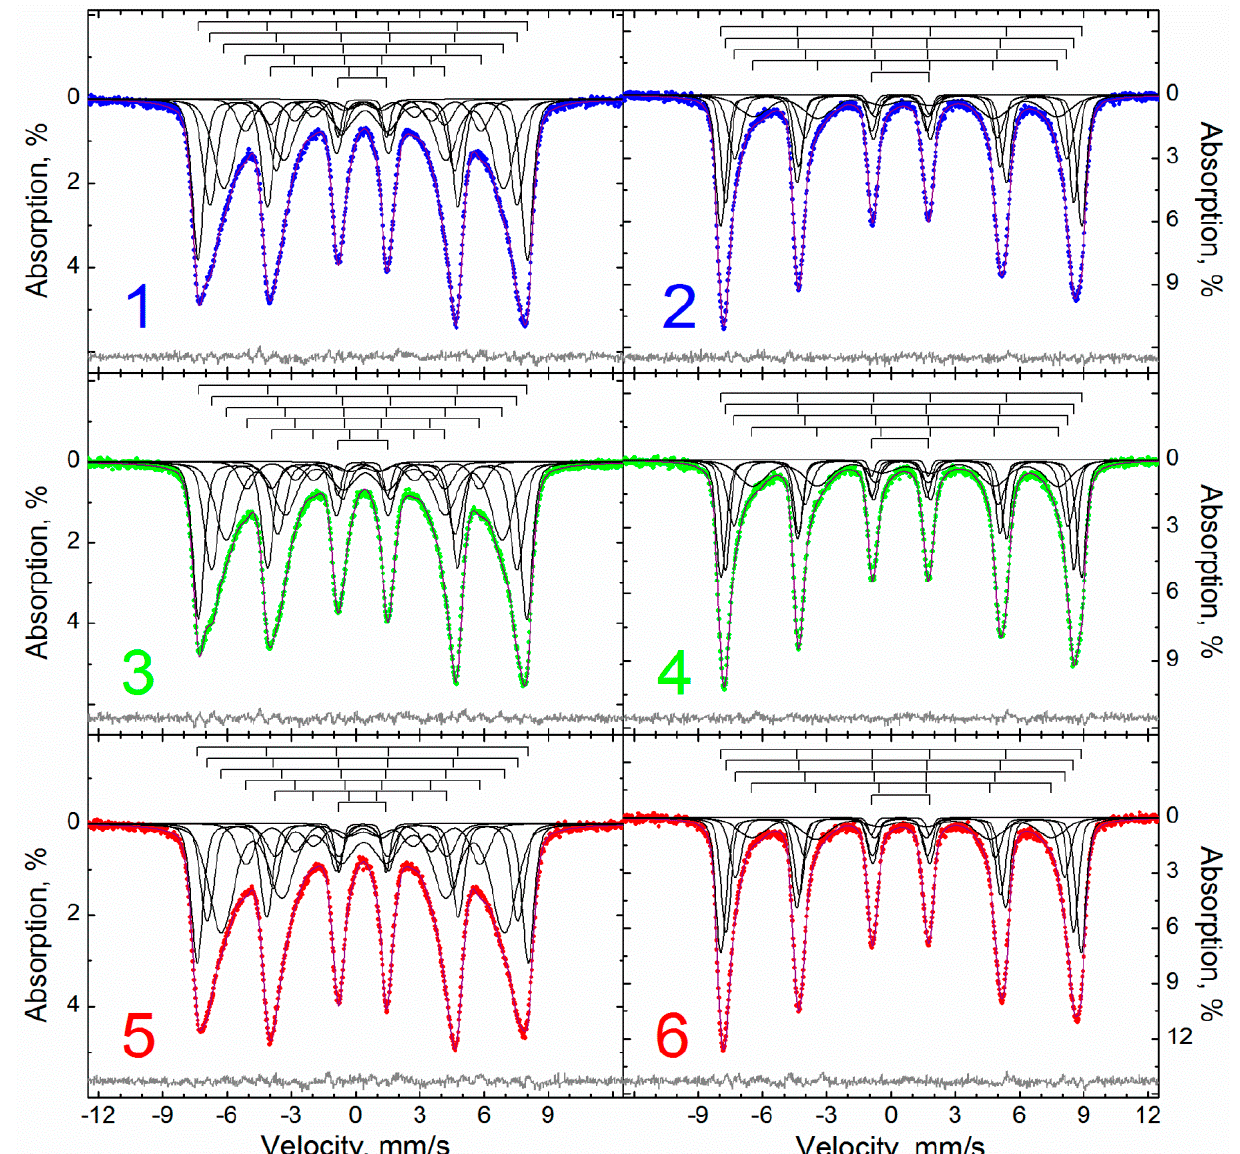
Figure 2. Description of the Mössbauer spectra within the framework of the “classical model” of samples: 1, 3, 5—M, MA, MAox measured at 295 K, and 2, 4, 6—M, MA, MAox measured at 78 K.